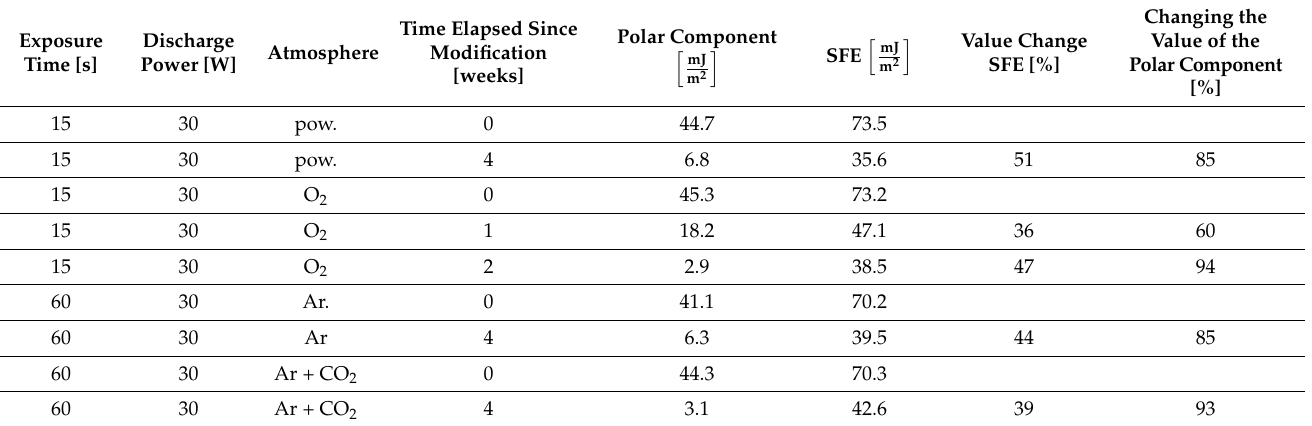
Table 3. Contact angles and calculated polar, dispersion, and free surface energy components of samples modified with barrier discharge with the time at which re-measurements were taken.